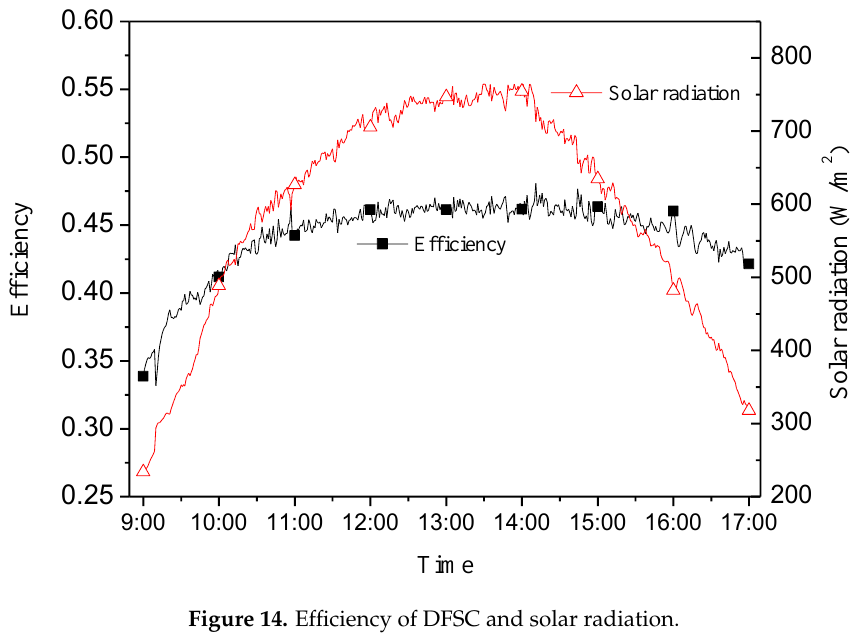
15 of 19 Figure 13. Electric power of test room and reference room. 4.3. Effect of Inner Structure